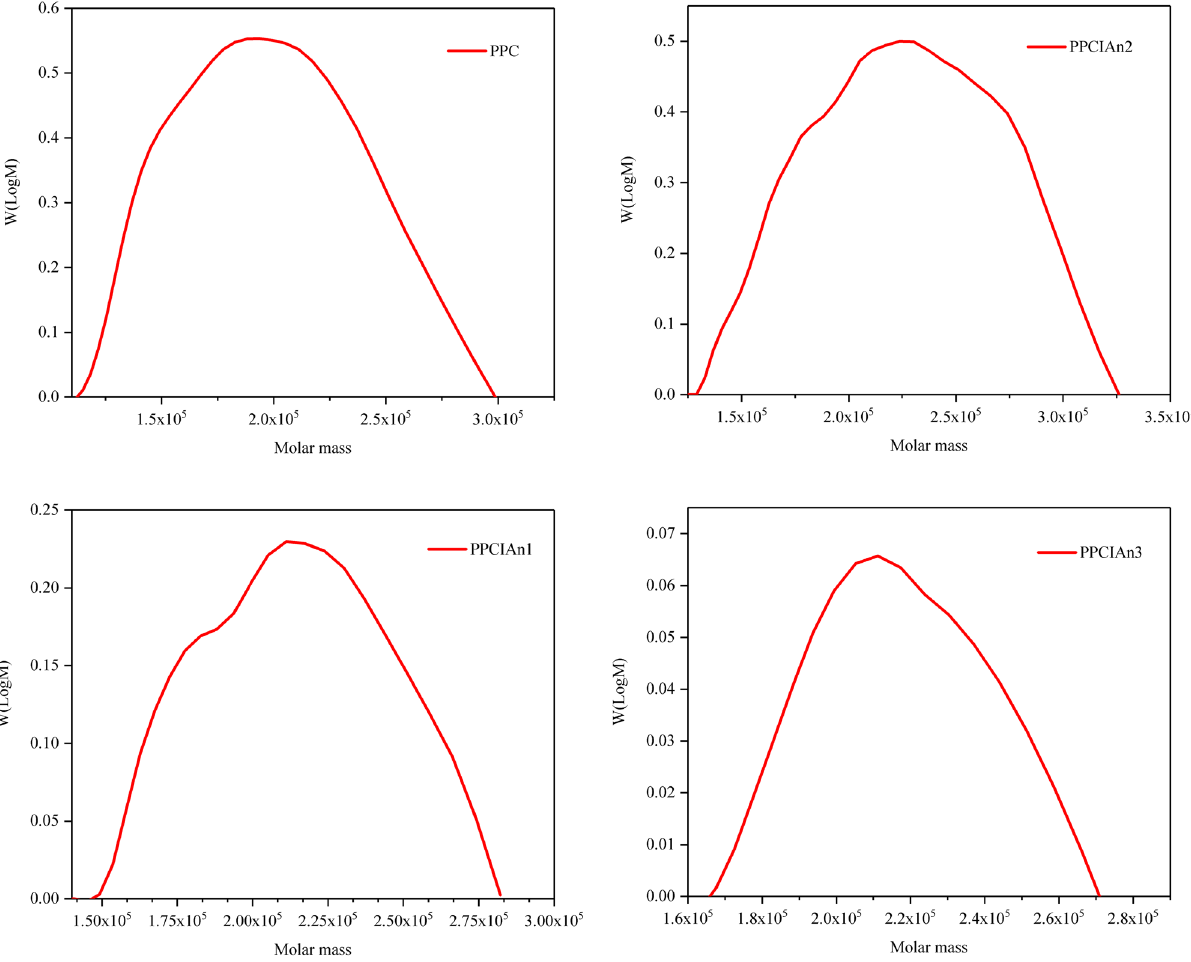
Figure A4: Molecular weight ( M w ) distribution in PPC and